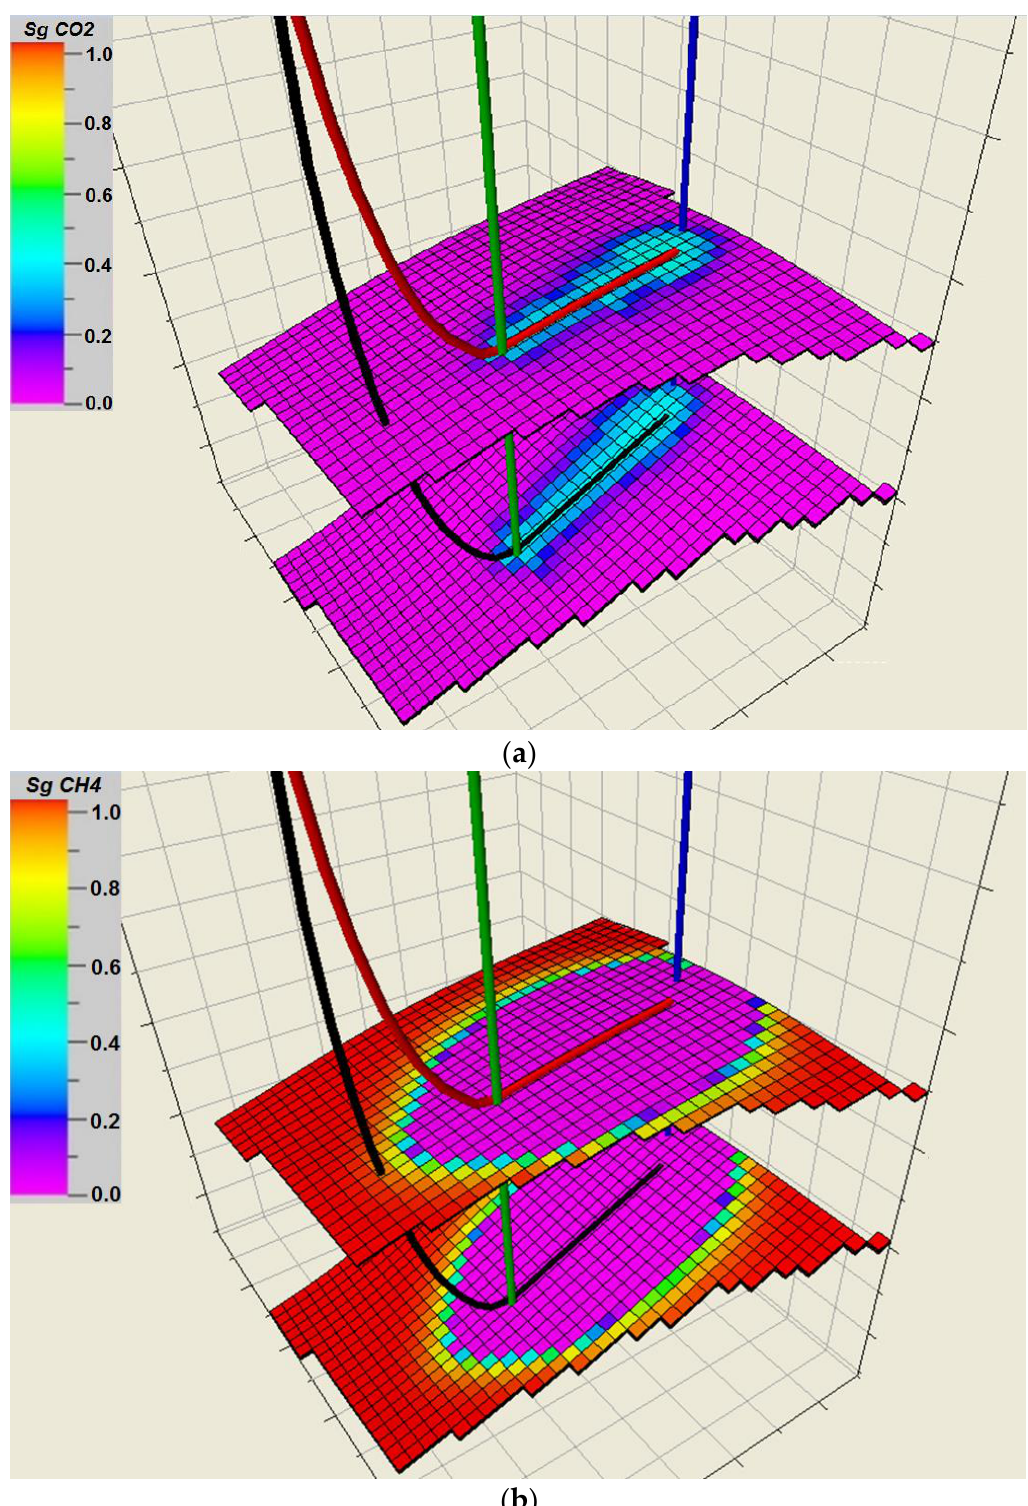
Figure 10. Changes in gas saturation- Sg : ( a ) CO 2 and ( b ) CH 4 in coal matrix after 1 year of CO 2 injection. (mole fractions of gases in coal matrix).